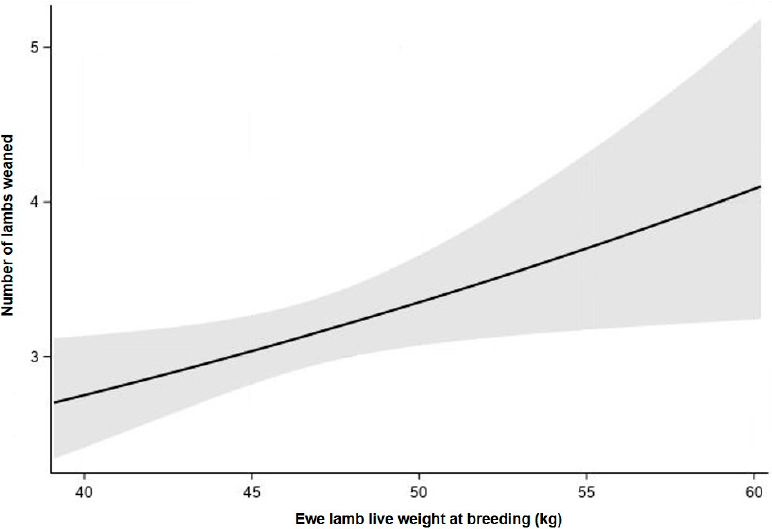
Figure 2. Number of lambs weaned over the three-year period in relation to ewe lamb live weight at breeding (d213) (log predictions (solid line) and 95% confidence intervals shown (grey area)).